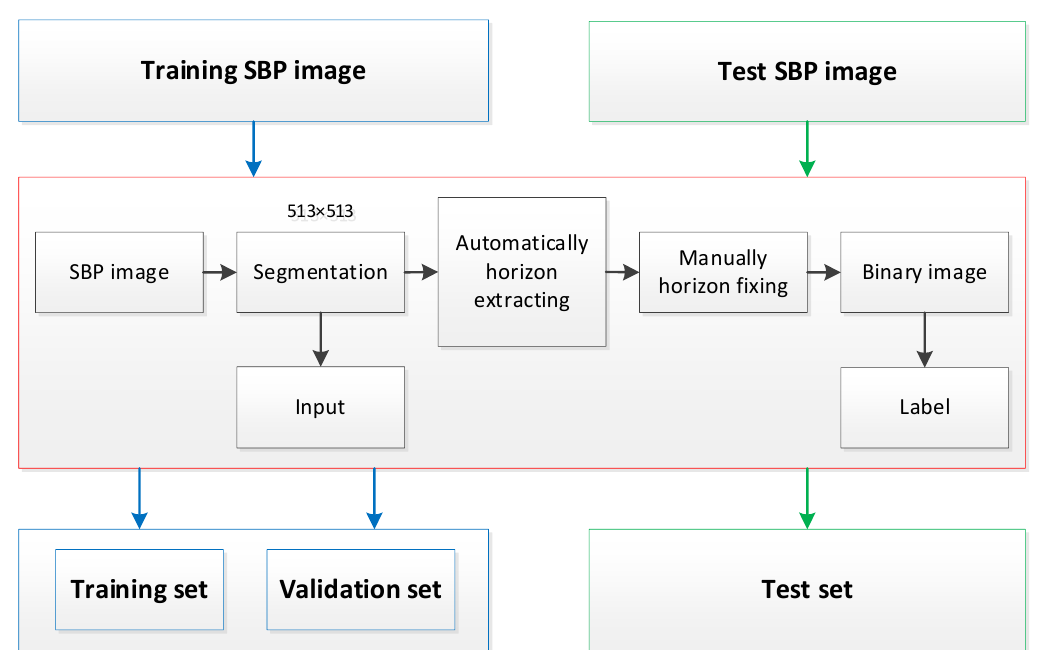
Figure 3. Generation process for training dataset. SBP images are broken into tiles. Each tile is an input to the neural network. For each tile, the horizon locations are tracked by the automatic method first and then are examined and restored artificially. Afterward, we create a tile of the same dimension as the input and fill the horizon locations with gray values of 1 and the remaining locations with 0. The corresponding binary tile is the label. All the data are divided into 2 groups, training dataset and validation dataset, according to the ratio of 3:1.